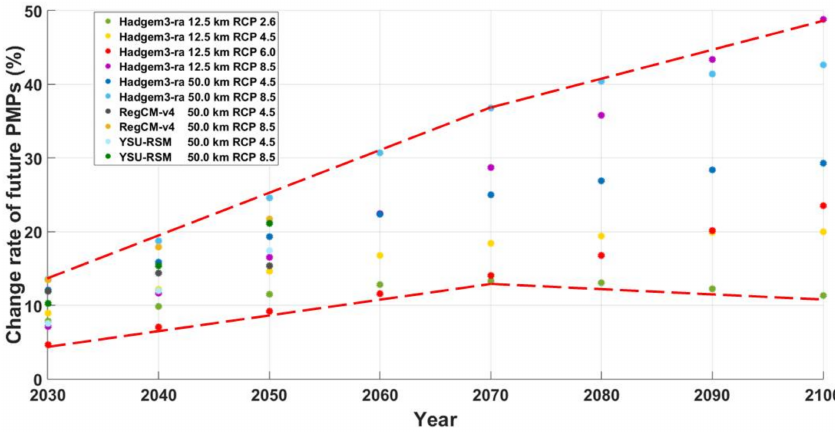
Figure 16. Temporal evolution of the rate of change of future